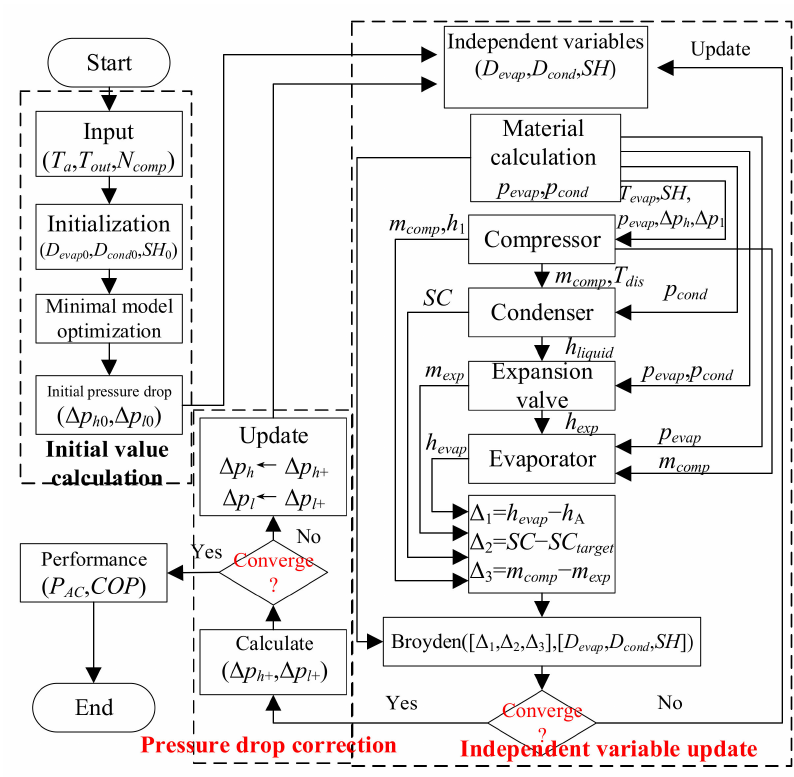
Figure 4. Flow chart of air conditioning system simulation calculation.